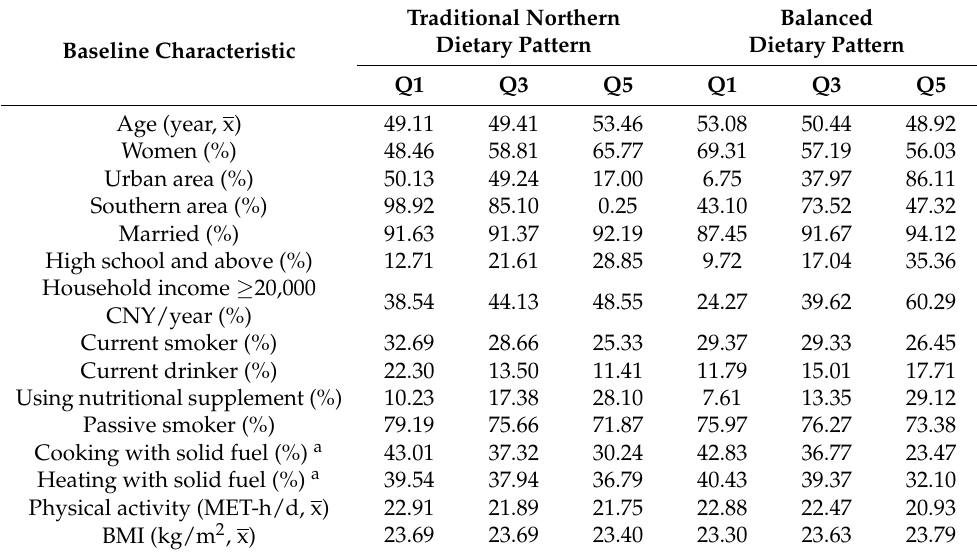
Balanced Dietary Pattern